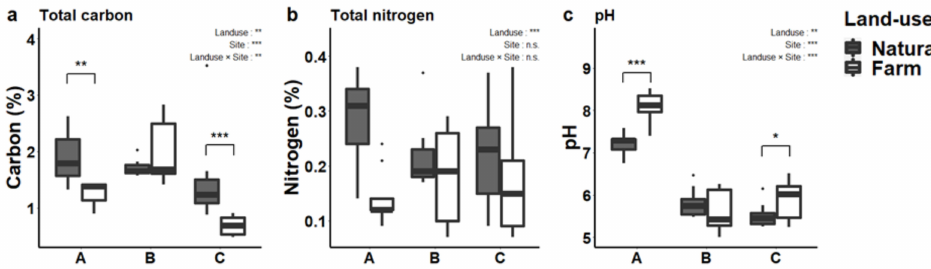
Figure 1. Basic properties of the soils. The data were analyzed with two-way ANOVA: ( a ) Total carbon content; ( b ) Total nitrogen content; ( c ) Soil pH. When there was a significant interaction between the land-uses and the sites, pairwise comparison tests were performed for the land-uses for each site and the significances are shown as *, ** or ***, representing p < 0.05, p < 0.01, or p < 0.001, respectively. The upper/lower whisker indicates the hinge to the highest/lowest value that is within 1.5 times the interquartile range (IQR) of the hinge, where the IQR is the distance between the first and third quartiles. Points outside the IQR are shown as outliers.